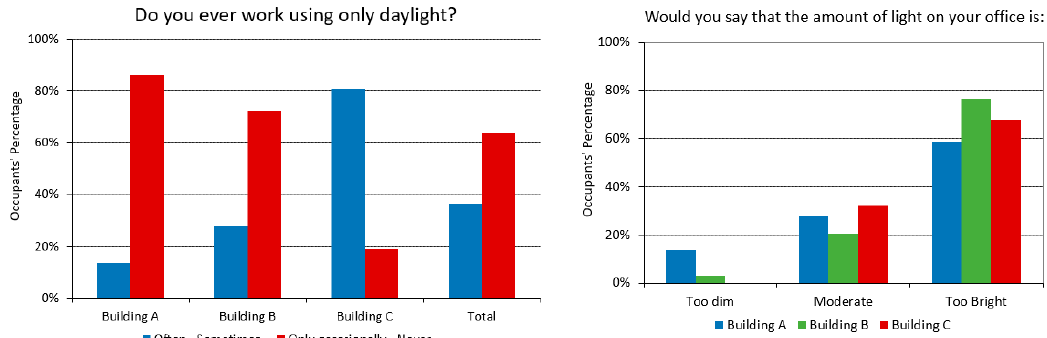
Figure 10. Results for how the users prefer their lighting conditions ( left ) and how important is for them to have a window in their office ( right ).